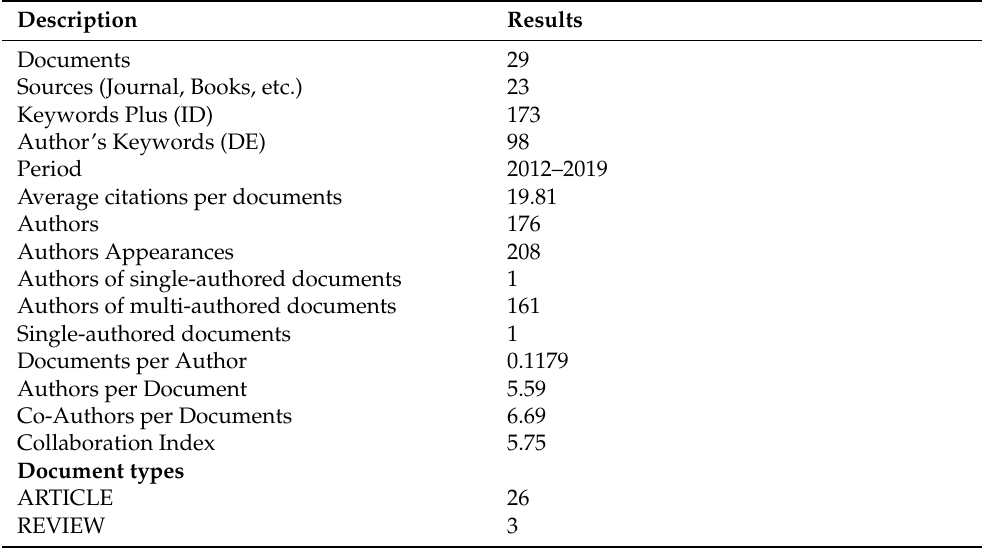
Table 1. Bibliometric data from the analysed documents.